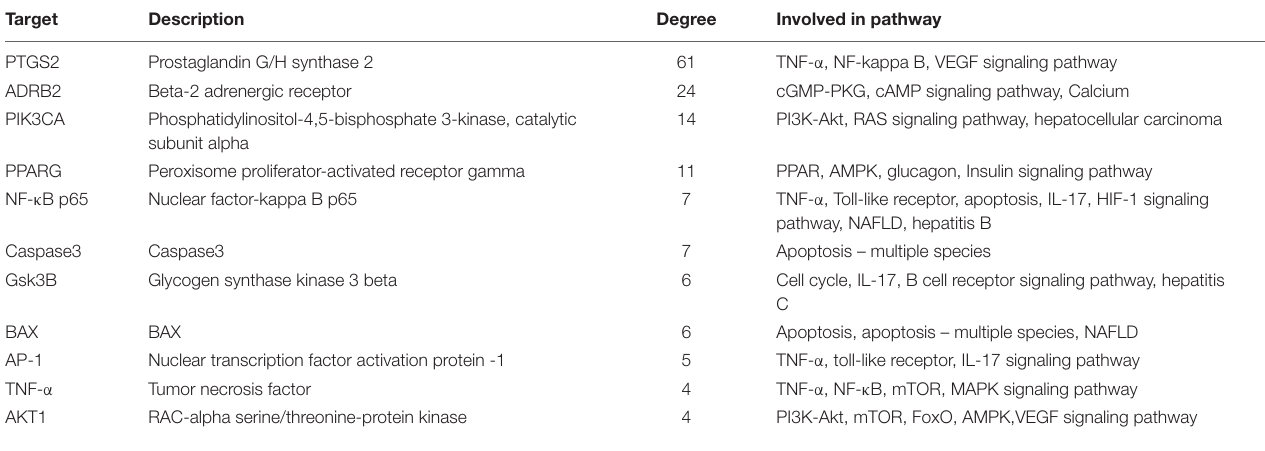
TABLE 2 | The potential targets and their network degrees and related